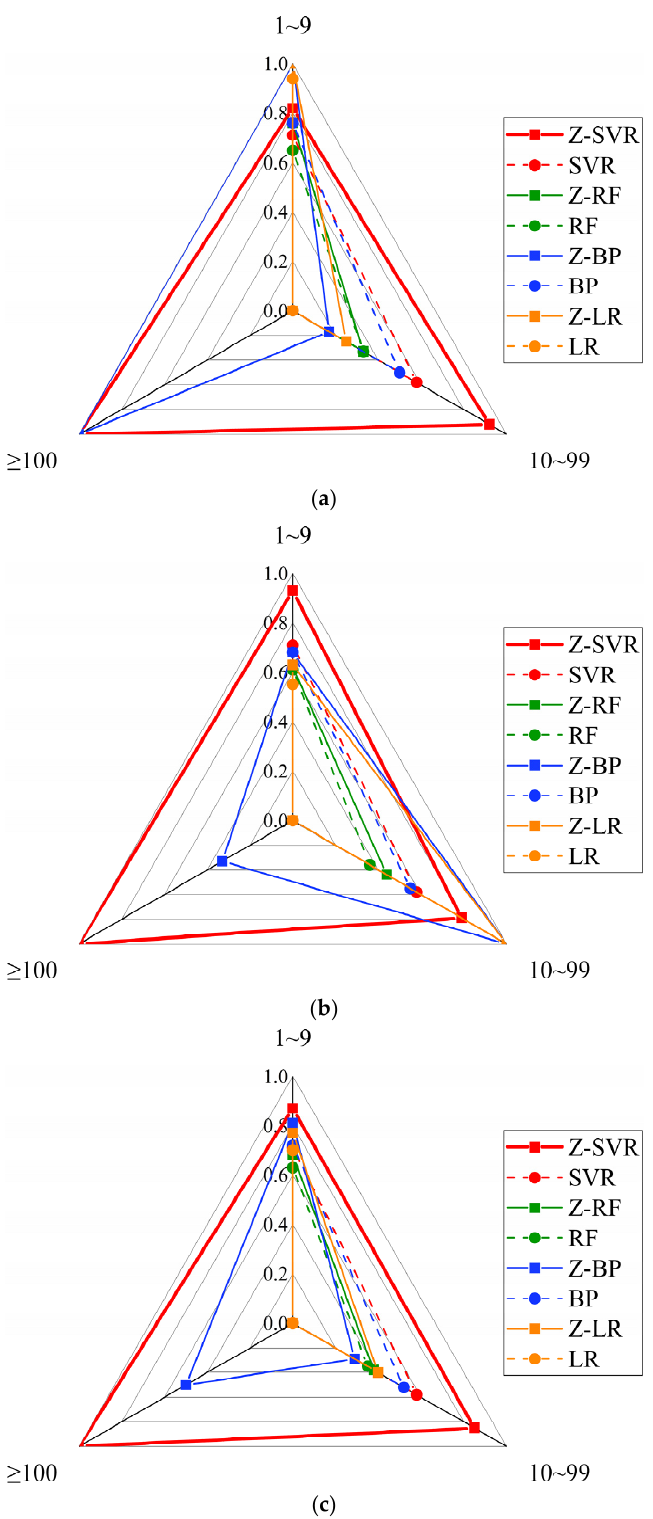
Figure 16. Classification results of Z-SVR and other models for earthquakes with casualties of different orders of magnitude: ( a ) Comparison of Precision ; ( b ) comparison of Recall ; and ( c ) comparison of F